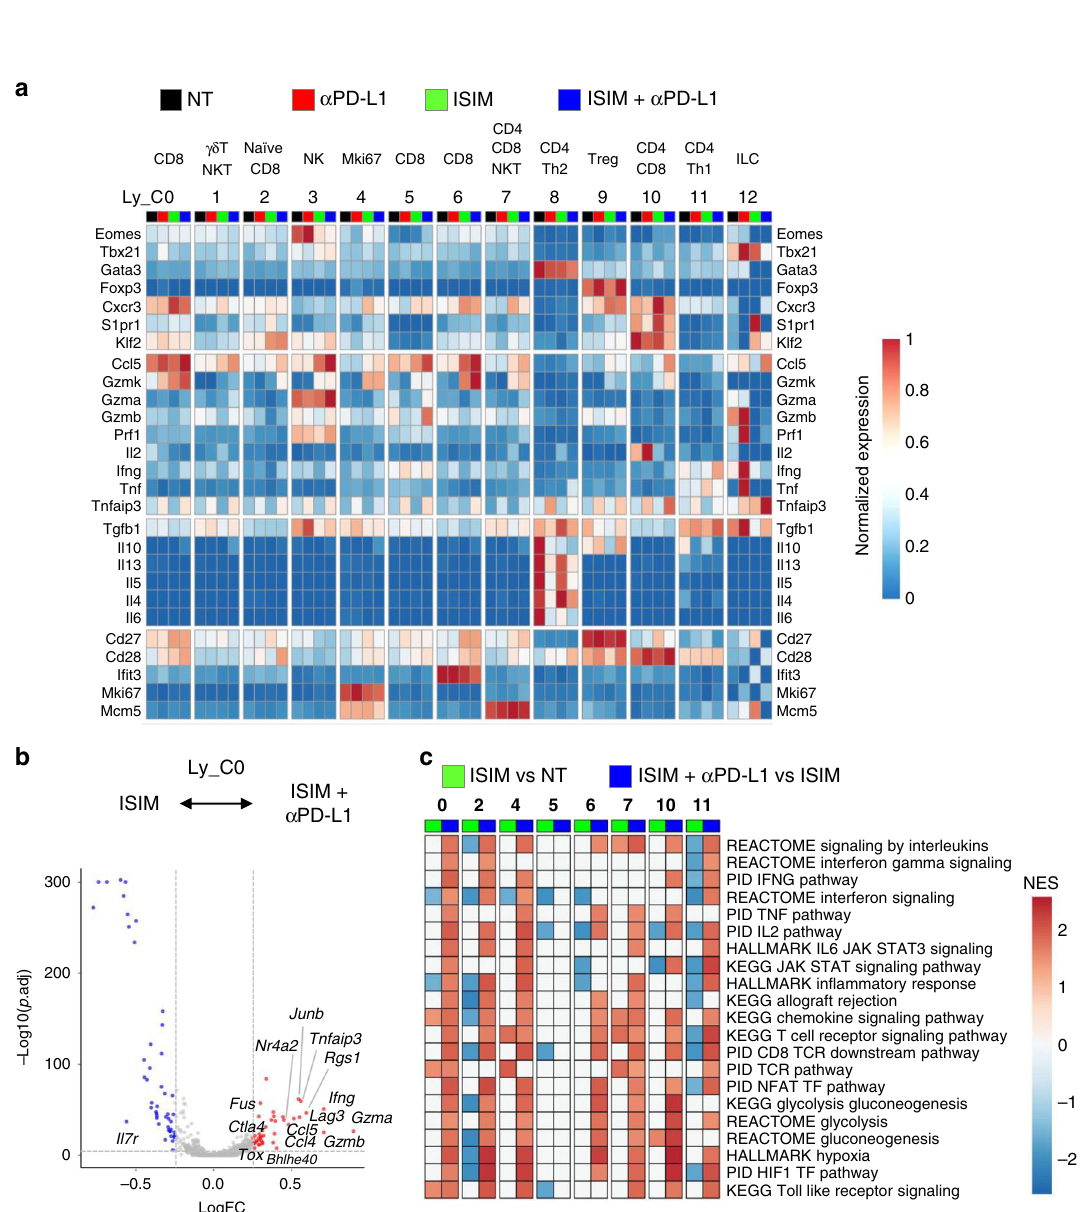
Fig. 8 PD-L1 blockade reshapes in situ immunomodulation (ISIM)-induced tumor-in fi ltrating lymphocytes. a Heatmap displaying normalized expression of select genes in each lymphoid cell cluster in tumors treated with PBS + isotype Ab (NT), PBS + anti-PD-L1 Ab ( α PD-L1), ISIM + isotype Ab (ISIM), or ISIM + anti-PD-L1 Ab (ISIM + α PD-L1). b Volcano plot showing enrichment differentially expressed genes in lymphoid cluster (Ly_C) 0 between that treated with ISIM and with ISIM + α PD-L1. Each red and blue dot denotes an individual gene with Benjamini – Hochberg-adjusted p value <0.05 and log fold change >0.25. c Heatmap of gene set enrichment analysis (GSEA) of ISIM vs NT and ISIM + α PD-L1 vs ISIM in Ly_C 0, 2, 4, 5, 6, 7, 10, and 11 showing normalized enrichment score (NES). Gene sets of REACTOME, PID, HALLMARK, and KEGG are